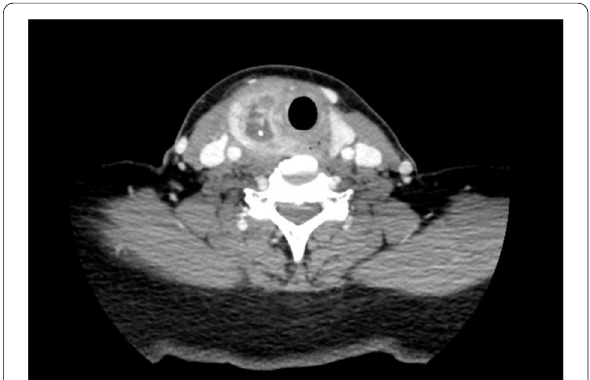
Fig. 1 CT scan neck with right thyroid lobe foreign body with surrounding fluid collection